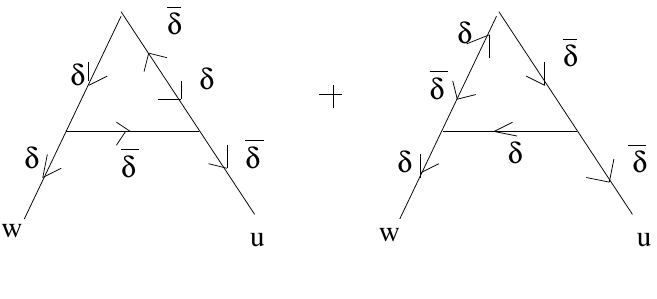
Figure 13 . Skeleton graphs for (cid:8) 12 ;C .